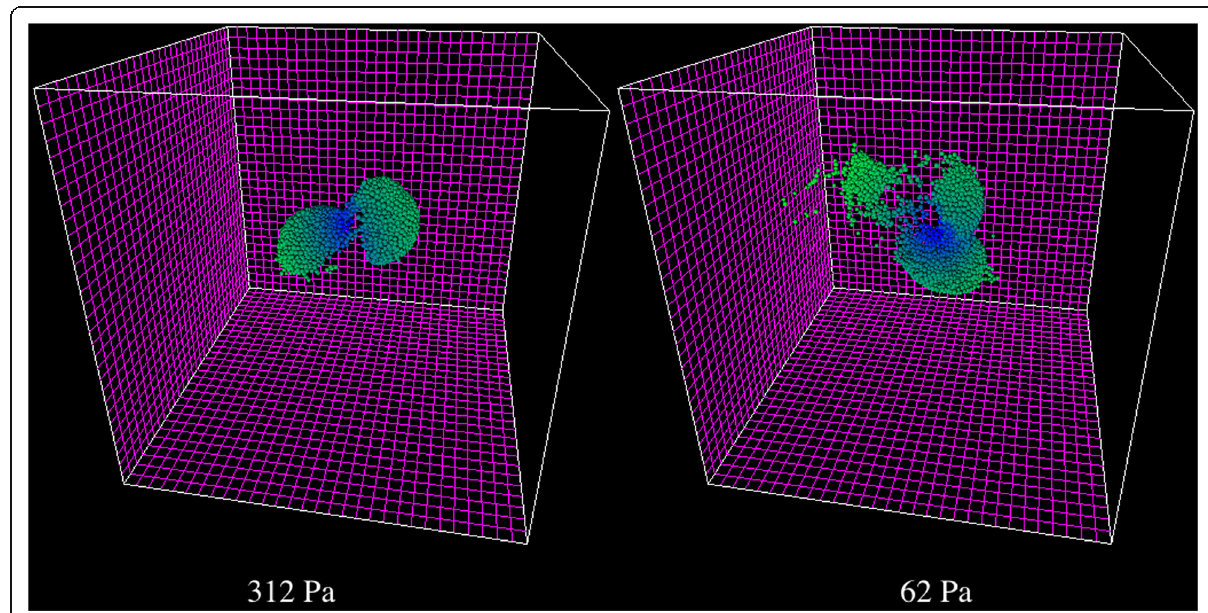
Fig. 4 Asteroid fission simulations, showing the effect of different levels of cohesion on the morphology of how the body splits. Figures taken from Sánchez and Scheeres